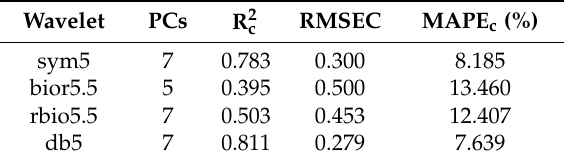
Table 2. Results of PLS model of various wavelet with fifth decomposition level.